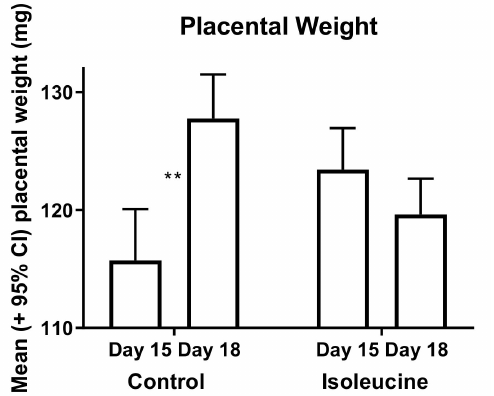
Figure 2. Placentas grew significantly between days 15 and 18 of pregnancy in the control mice (t-test, p < 0.0001), but not in the experimental mice. Double asterisks (**) indicate mean values that are significantly di ff erent from each other (control day 15, n = 95 placentas and day 18, n = 128 placentas; experimental day 15, n = 123 placentas and day 18, n = 164 placentas). CI—confidence interval. Fetal Cl Fetal Weight en .§. 1275